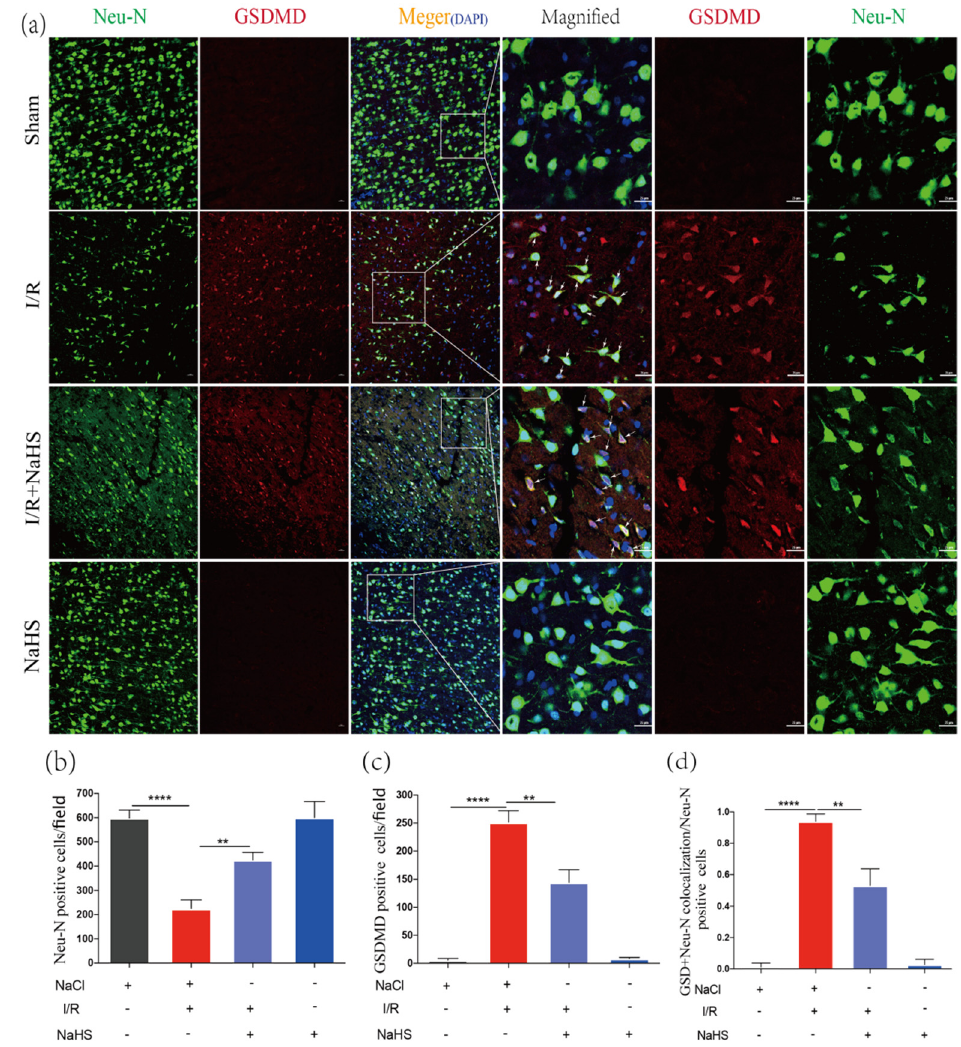
Figure 5. NaHS inhibited I/R-induced neuron pyroptosis in the rat brain cortex. ( a ) Immunofluores- cence staining of Neu-N and GSDMD in the peri-infarct region. Scale bar = 50 μ m. Scale bar = 25 μ m in magnified images. Arrows indicate Neu-N and GSDMD double-positive cells. ( b ) Analysis of Neu-N Positive cells in the brain cortex ( n = 3). ( c ) Analysis of GSDMD-positive cells in the brain cortex ( n = 3). ( d ) Analysis of the ratio of the Neu-N and GSDMD double-positive cells to the Neu-N positive cells in the brain cortex ( n = 4). Data are represented as means ± SD. ** p < 0.01, **** p < 0.0001.